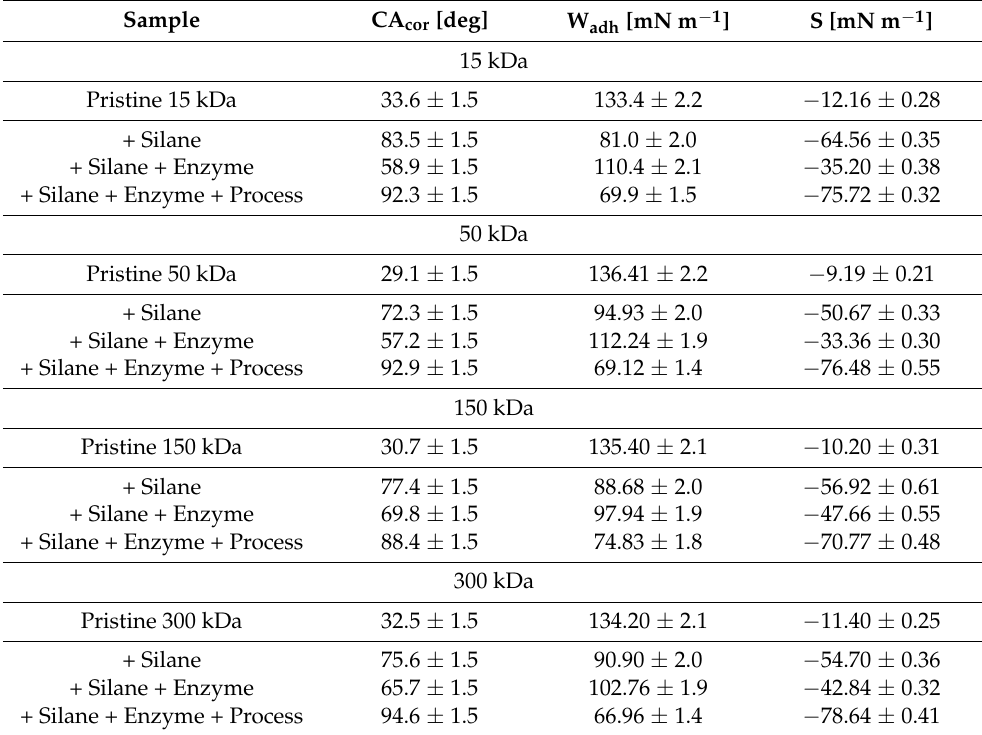
Table 2. Wettability study of the investigated samples: contact angle corrected by the roughness (CA cor ), work of adhesion (W adh ), and spreading pressure